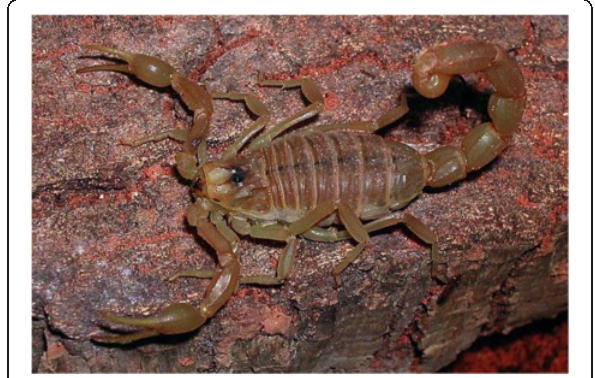
Fig. 2 Buthus occitanus (Amoreux, 1789); female from France (copyright by Eric Ythier, reproduced with